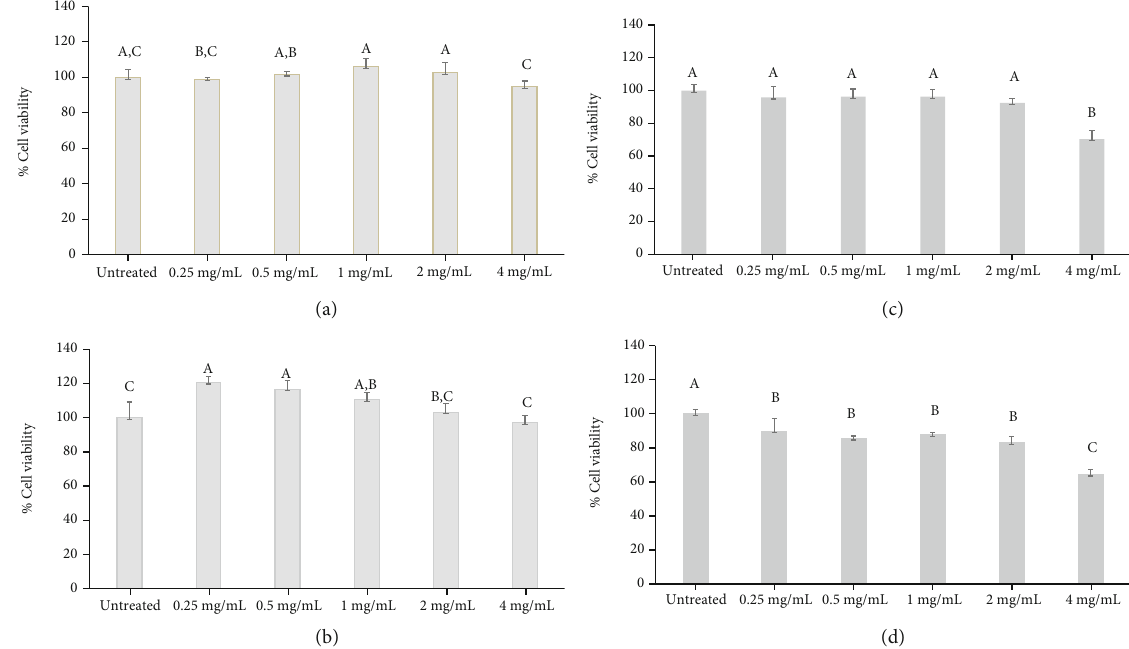
Figure 2: E ff ect of Momordica cochinchinensis aril extract on sensory quality of sterilized milk. Data are presented as means ± SD ( n = 30 ). Statistical comparisons were made between samples using one-way ANOVA